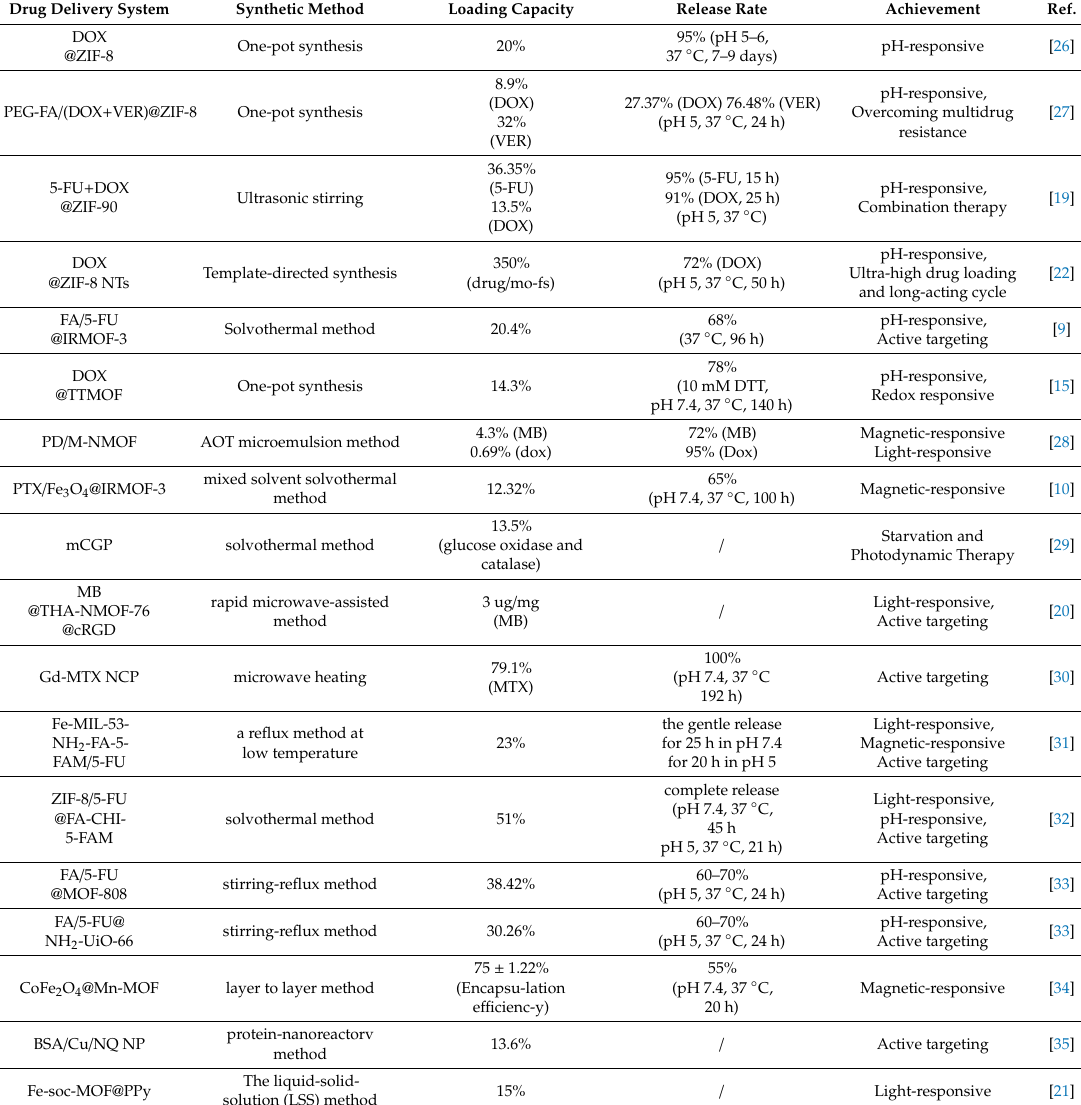
Table 1. Synthesis and functionalization of metal organic frameworks.